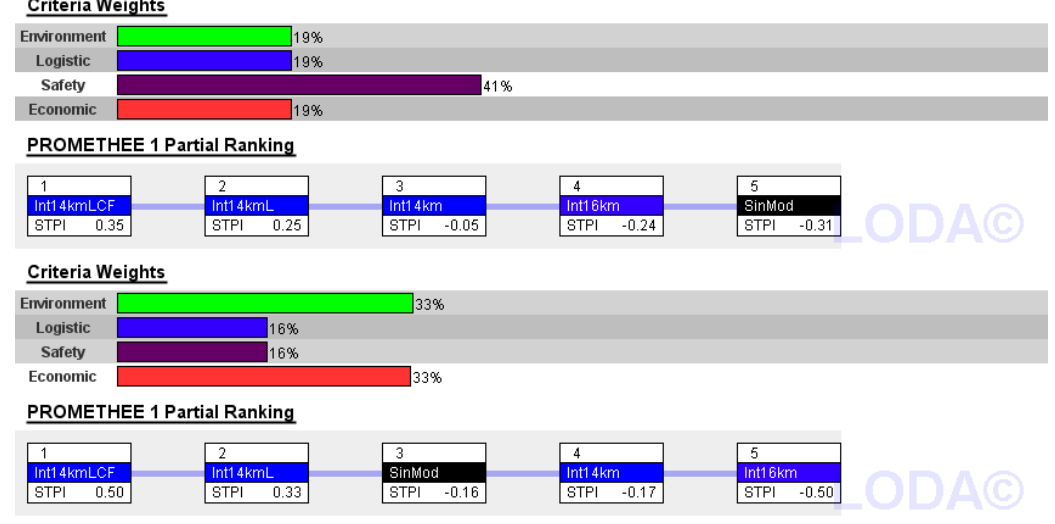
Figure 7. Robustness/Sensitivity